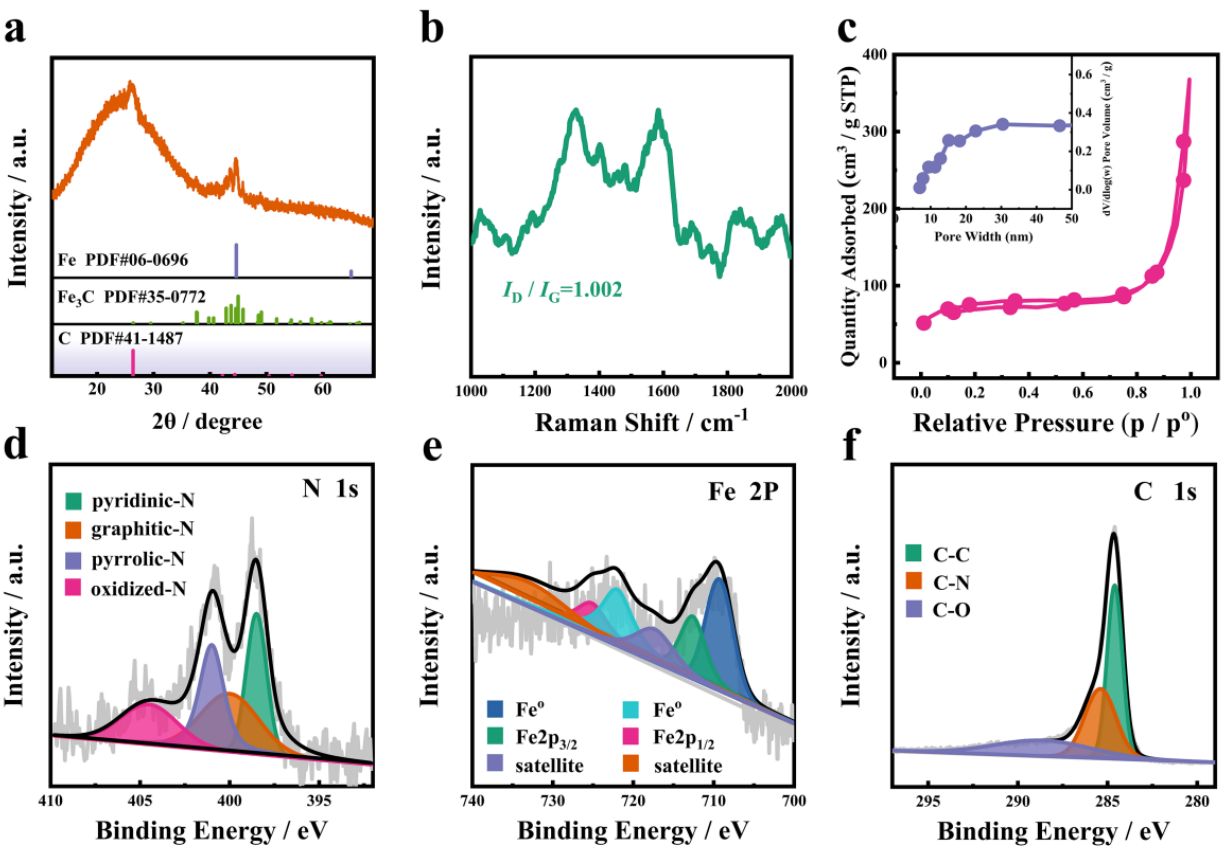
Figure 2. ( a ) XRD pattern, ( b ) Raman spectra, ( c ) pore size distribution and N 2 -sorption isotherm, ( d – f ) N 1s, Fe 2p and C 1s XPS spectra of the SiO 2 @Fe 3 C/Fe@NCNT-GT.